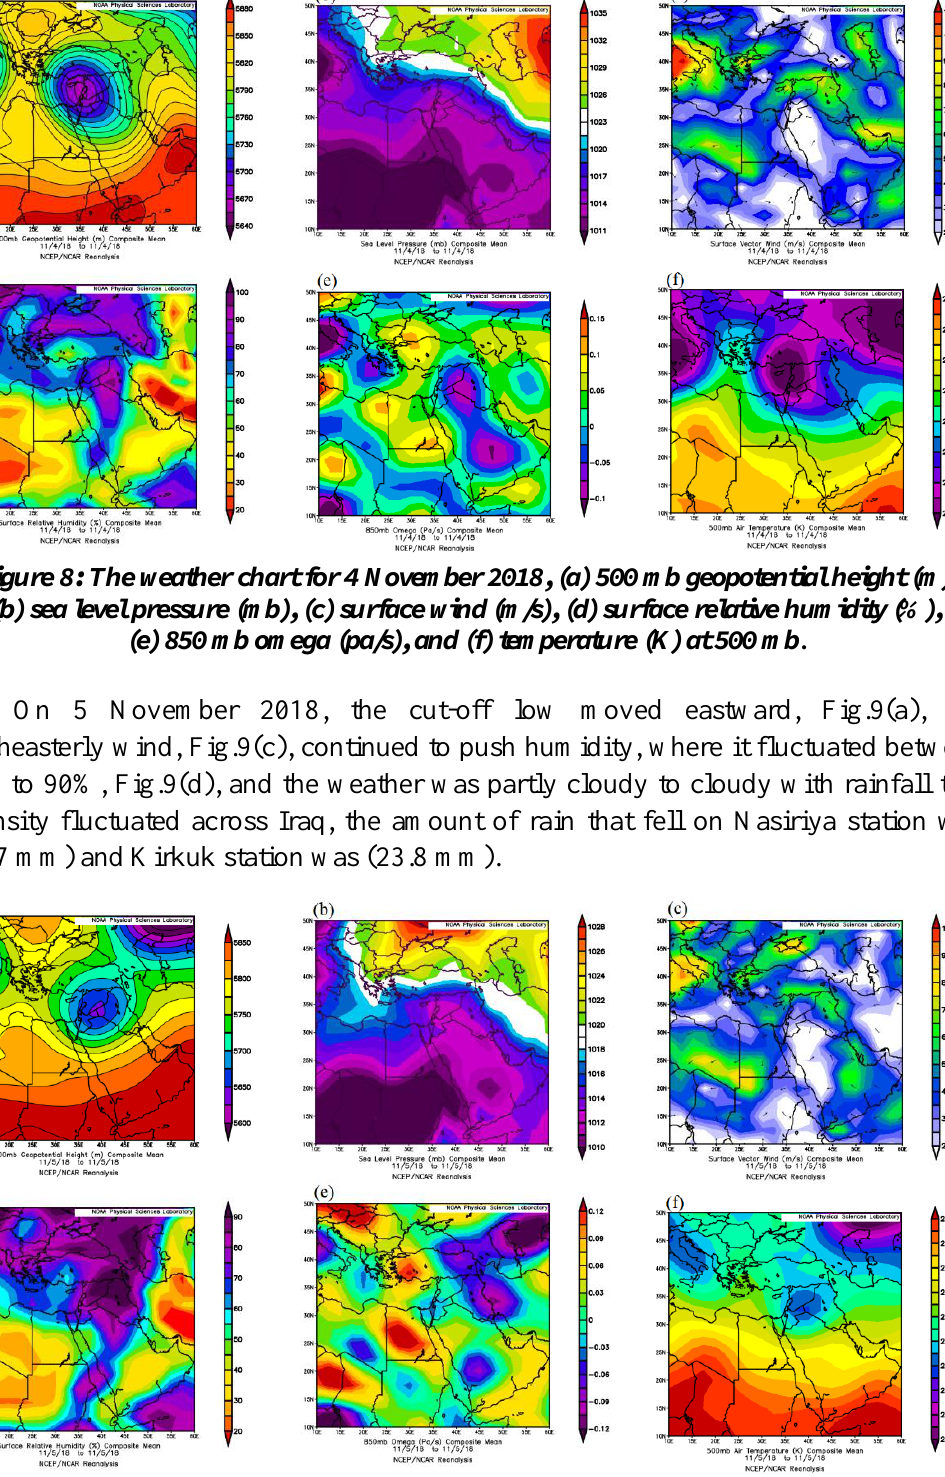
Figure 9: The weather chart for 5 November 2018, (a) 500 mb geopotential height (m), (b) sea level pressure (mb), (c) surface wind (m/s), (d) surface relative humidity (%), (e) 850 mb omega(pa/s), and (f) temperature(k) at 500